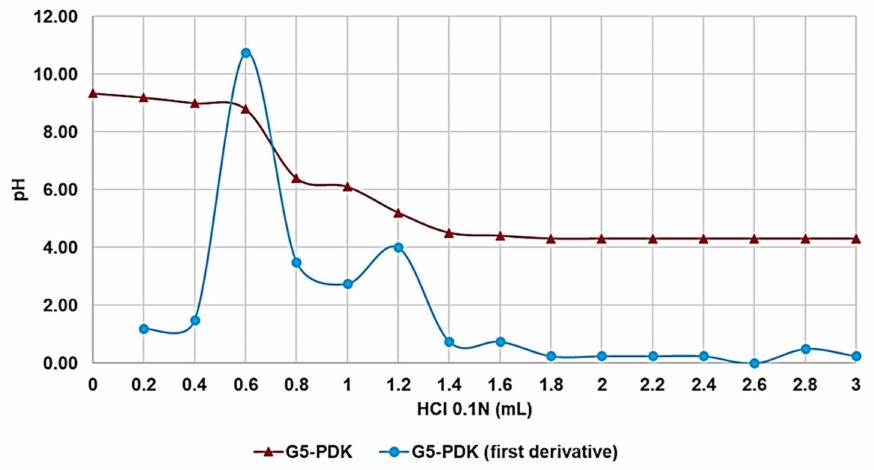
Figure 4. Titration curve of G5-PDK (red line); first derivative line of the titration curve (light blue line).